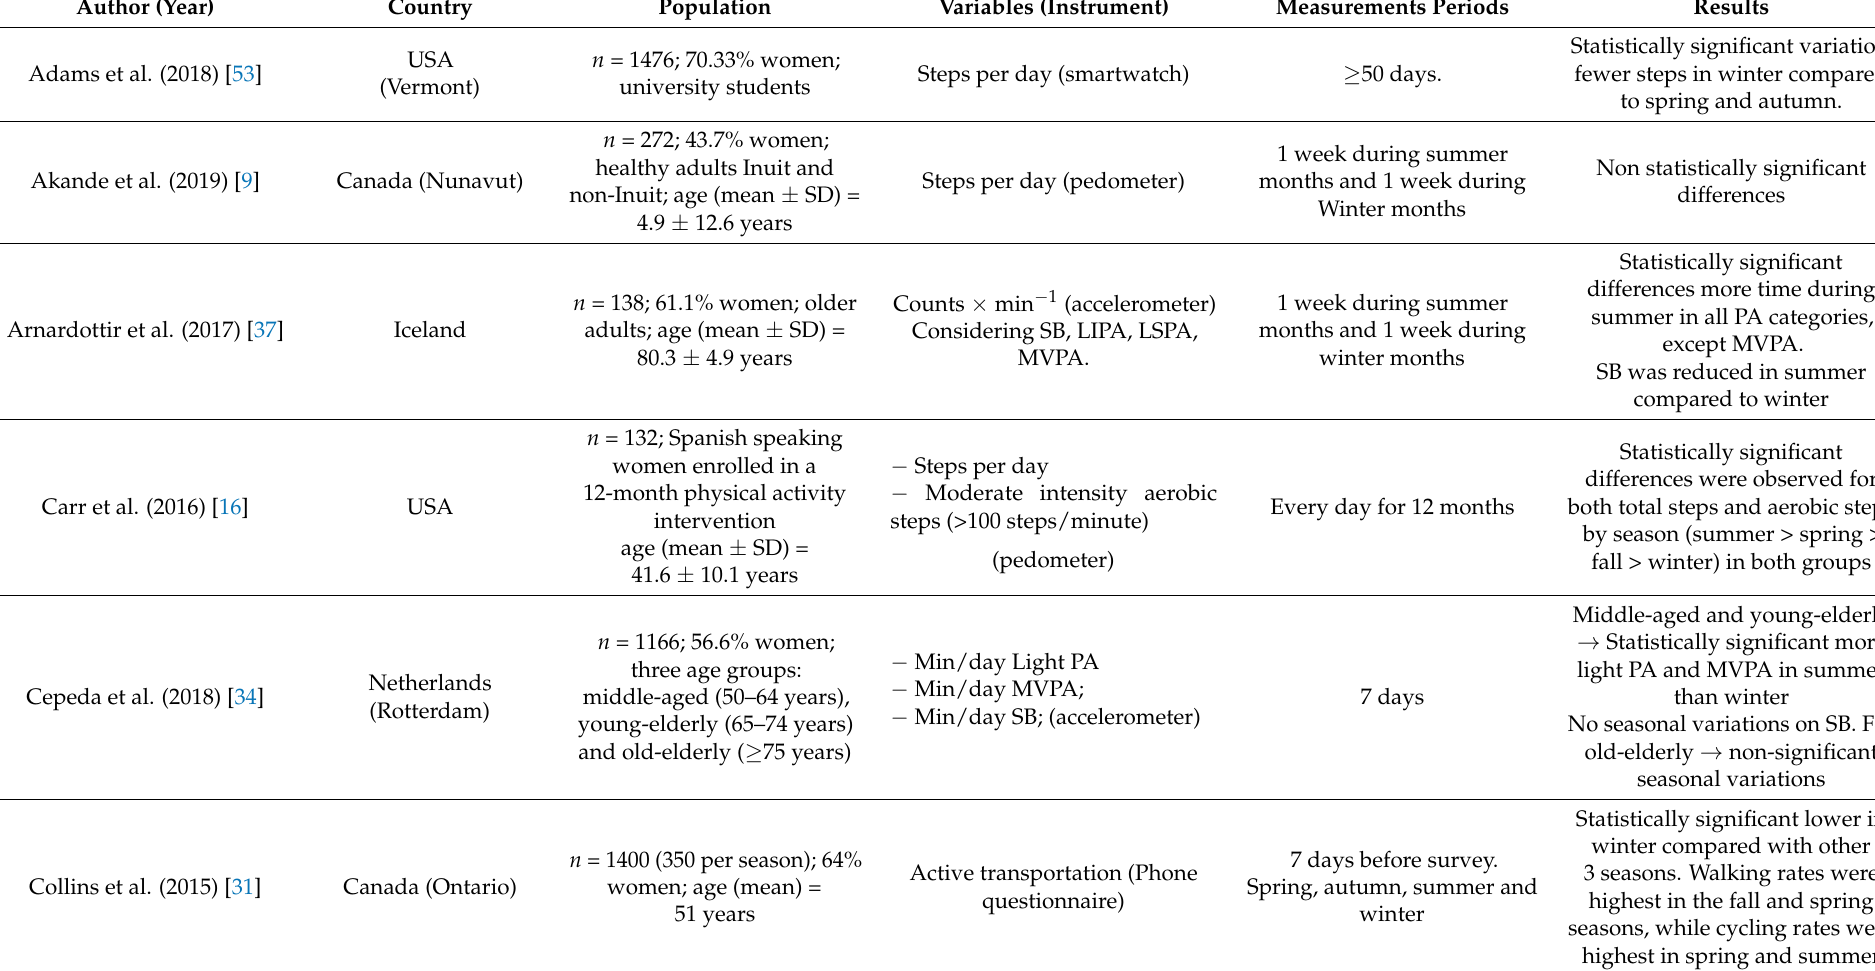
Table 2. Population, variables and results of the included